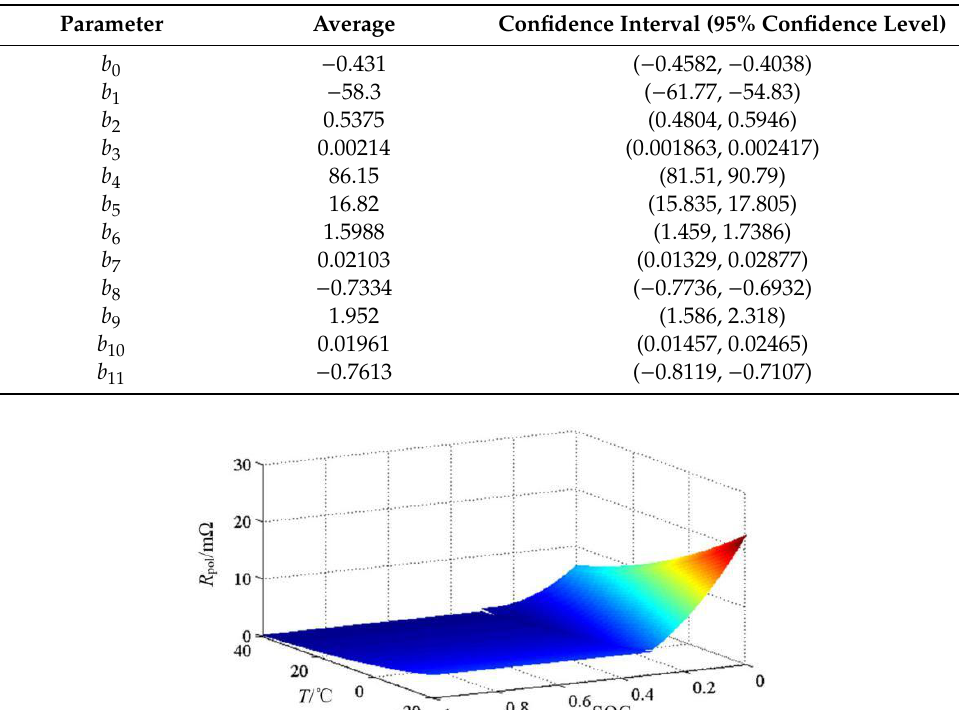
Table 2. Parameters of R pol .